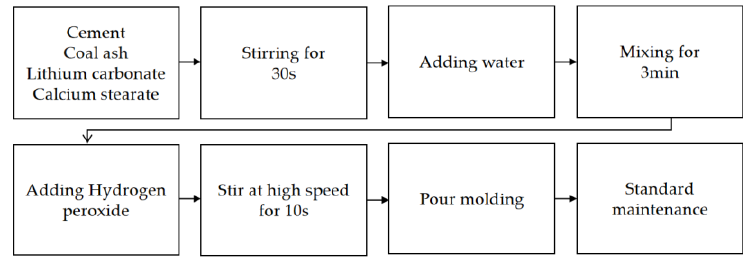
Figure 1. Preparation of foam concrete.